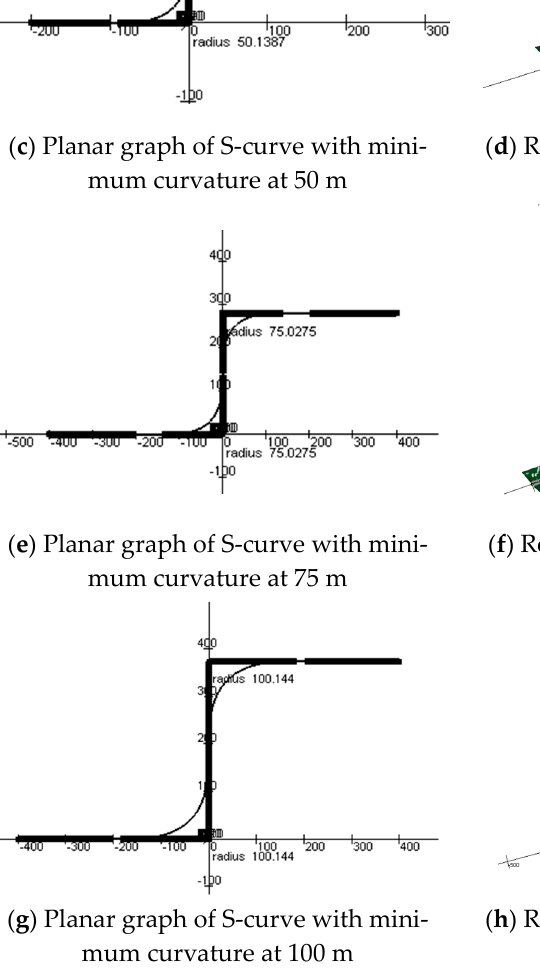
Figure 6. Driving scenarios prepared for the virtual night drive data collection. The curve varies from 25 m to 100 m, with the 25 m curvature corresponding to a vehicle traveling at minimum ADB deactivation speed, below which the ADB will automatically be deactivated and switch to low beam. The 100 m curvature corresponds to the minimum curvature that NHTSA proposed for ADB testing in NPRM [22].